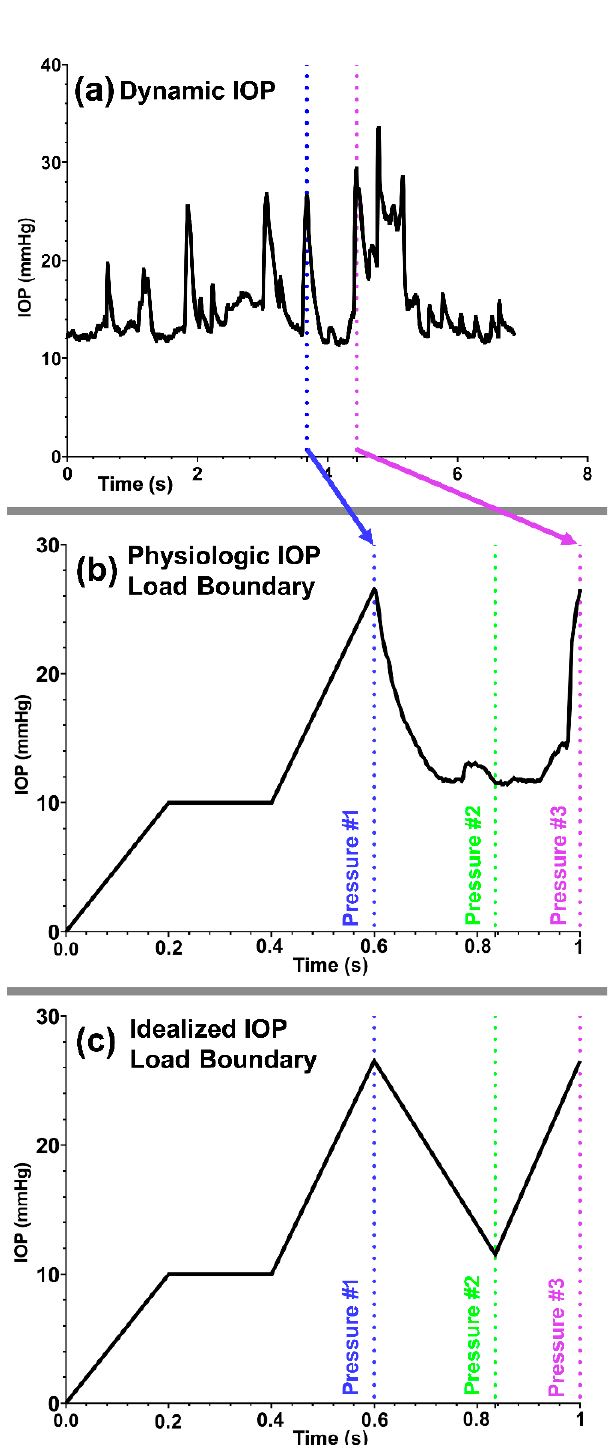
Figure 2. ( a ) Transient IOP fluctuations in a non-human primate (a rhesus macaque aged 4, male, right eye). ( b ) Physiologic and ( c ) idealized IOP load boundary with an IOP pre-load applied to the aqueous humor inflow.